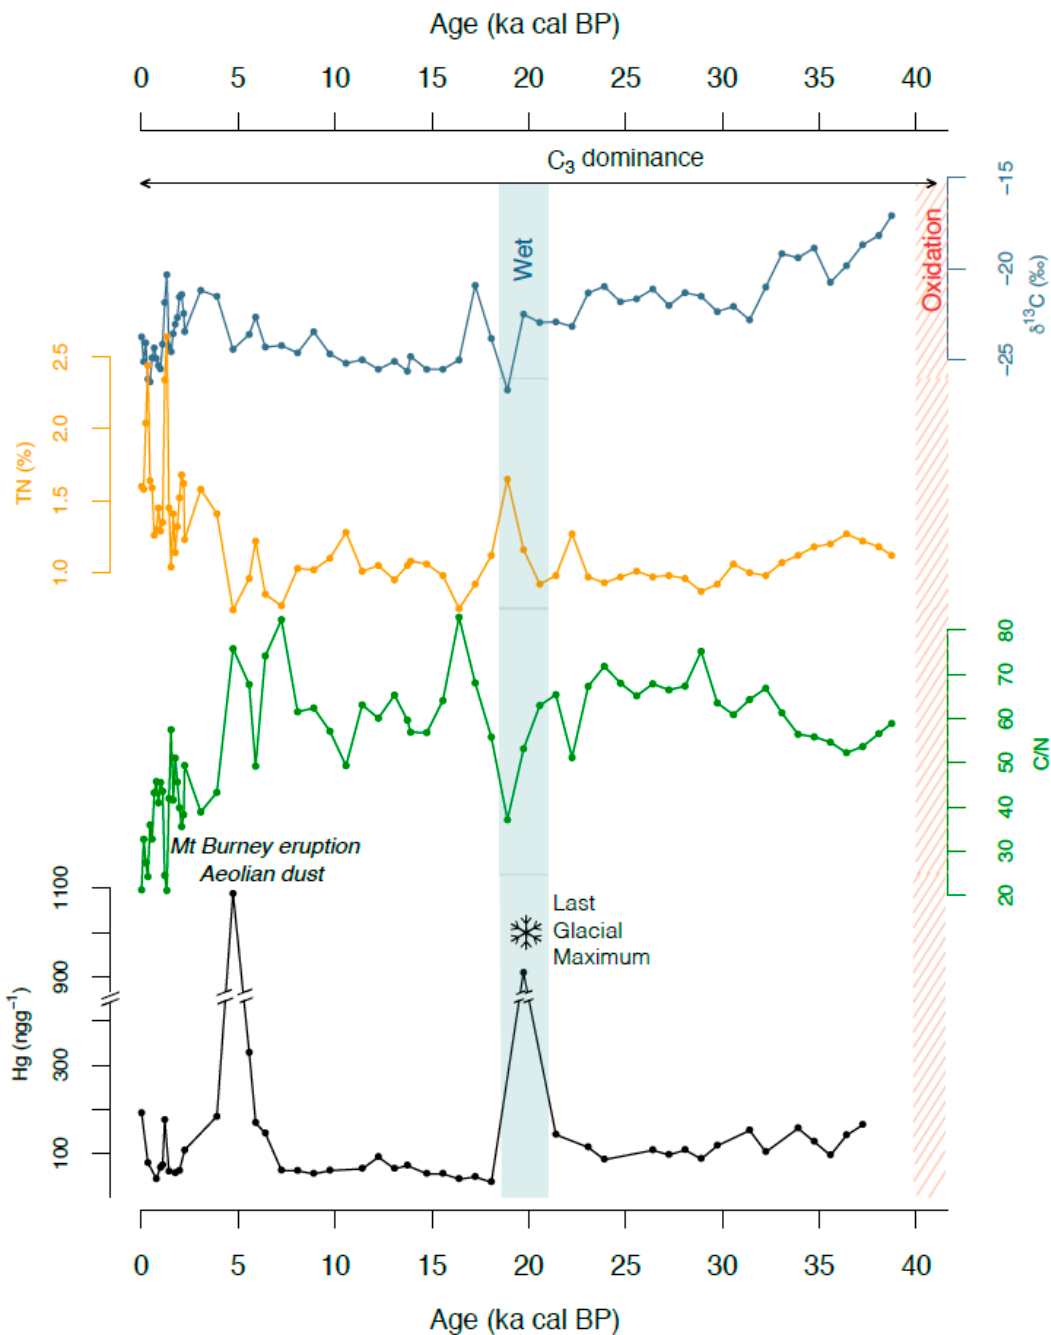
Figure 5. Mercury concentration and main proxies uses to reconstruct the environment in Rano Aroi in the last ca. 39.0 ka cal BP in the ARO 08 02 core; from bottom to top: Hg concentration, C/N, TN and δ 13 C) [32]. Wet events according to δ 13 C ( ‰ ) excursions that match with Hg concentration increases (blue bars); the dashed line indicates the position of the δ 13 C ( ‰ ) excursion in agreement with the literature (see text). Cold periods are indicated (*).